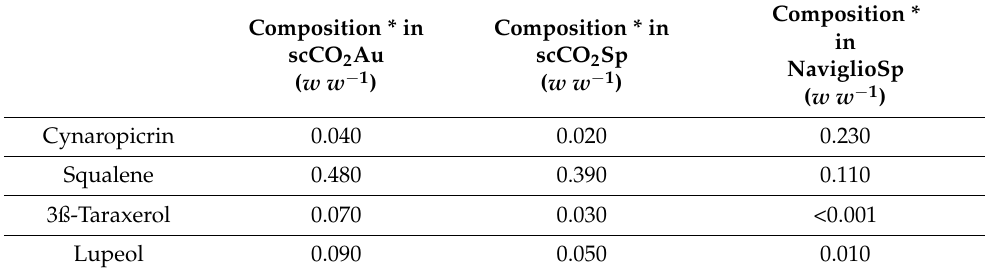
Table 1. Composition of the principal bioactive molecules in the three solutions of cardoon leaves extracts.